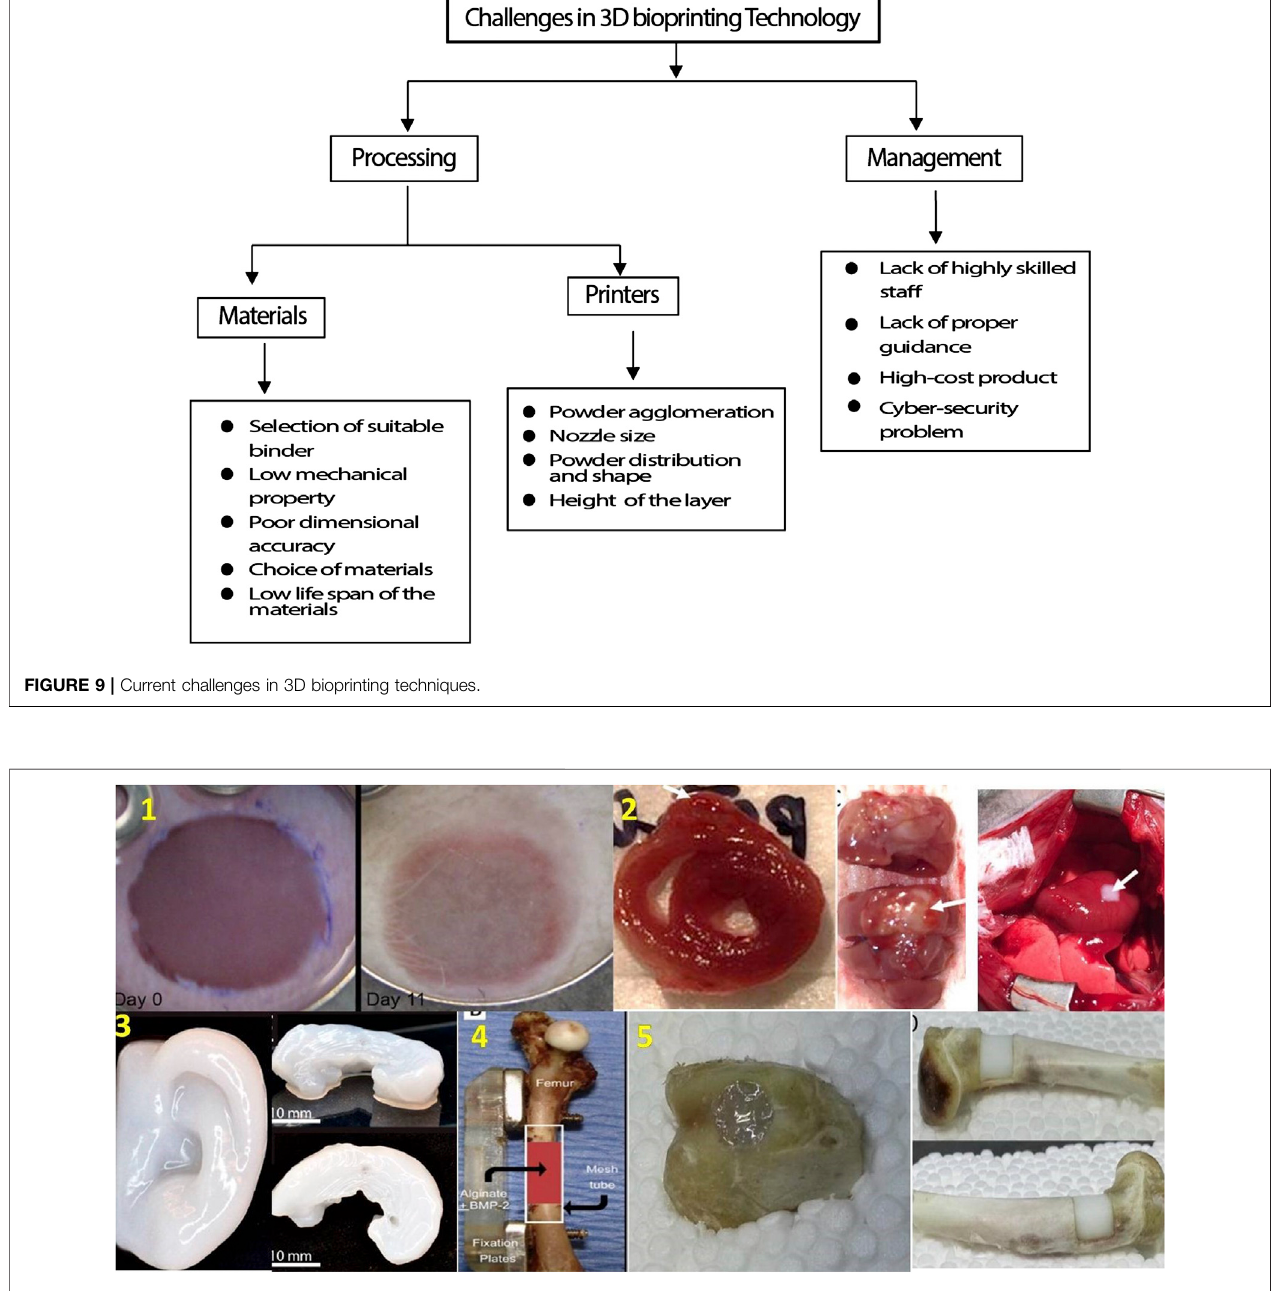
Frontiers in Mechanical Engineering |